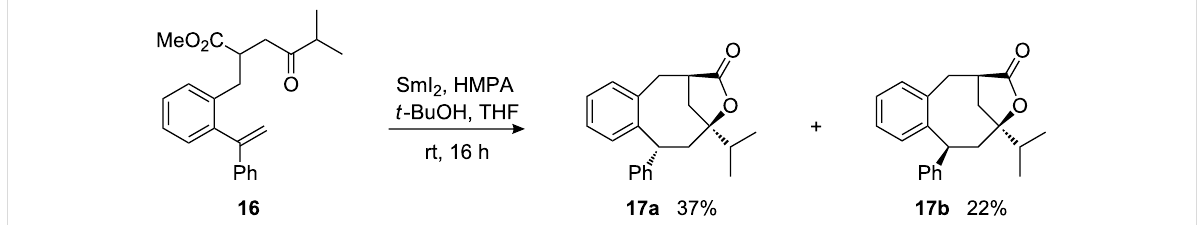
stabilized by the methoxycarbonyl group. Very surprisingly in